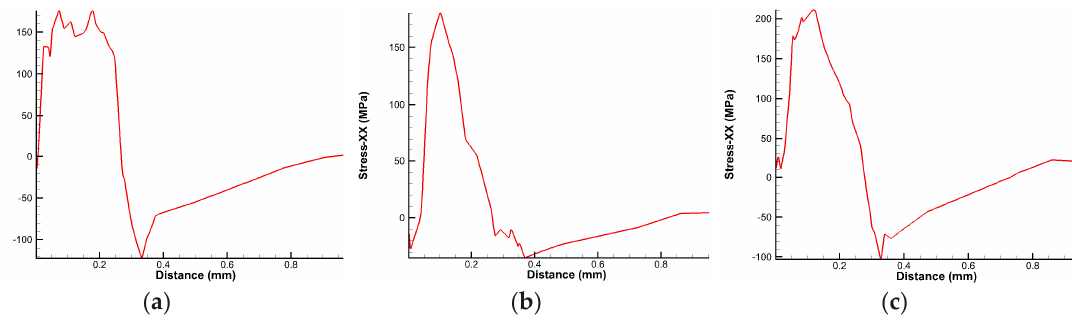
Figure 12. Residual stress of Workpiece Surface: ( a ) d = 80 µ m micro-hole tool; ( b ) d = 120 µ m micro-hole tool; ( c ) non-textured tool.